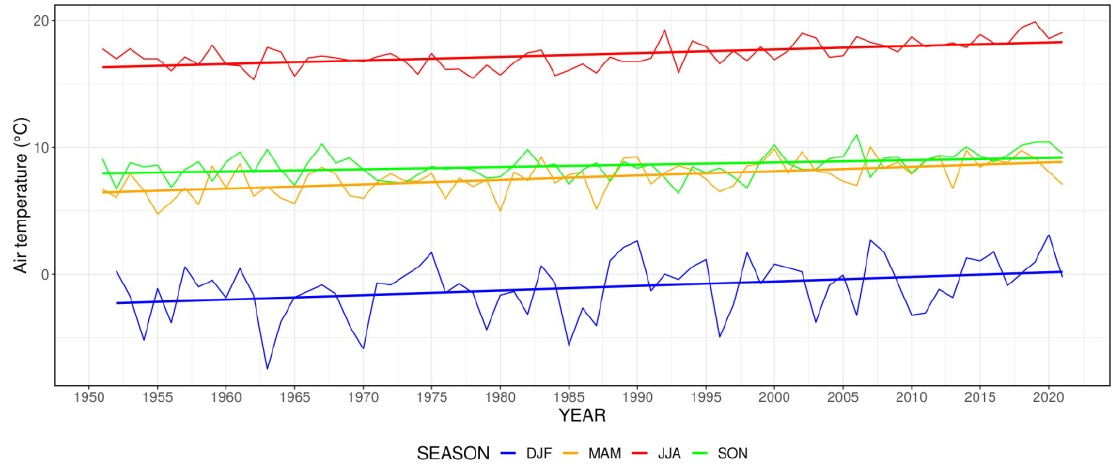
Figure 4. Course of area average seasonal air temperature in Poland (1951–2021).